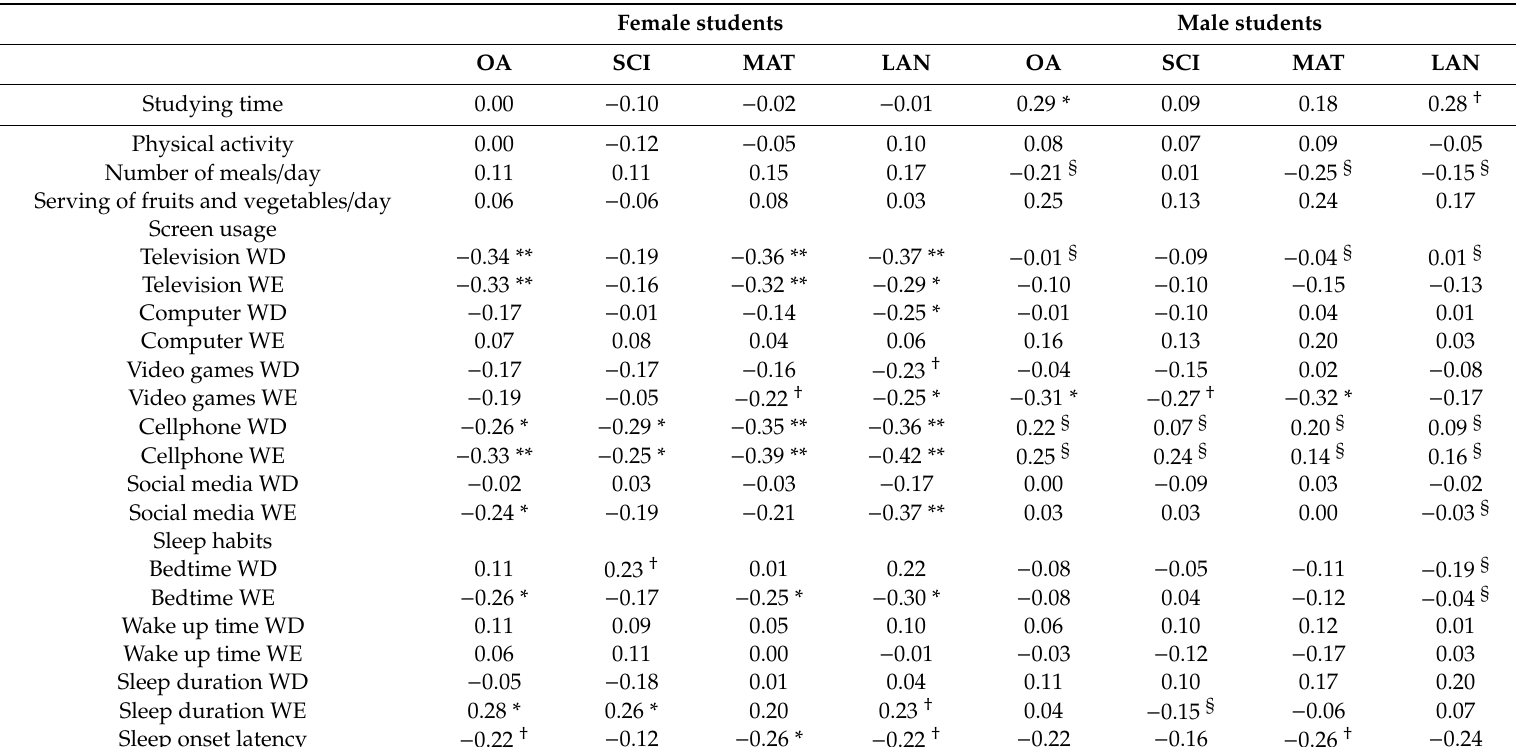
Table 4. Correlations between lifestyle habits with academic performance measures at baseline in high school female and male students. Female students Male students OA SCI MAT LAN OA SCI MAT LAN Studying time 0.00 Physical activity 0.00 Number of meals / day 0.11 Serving of fruits and vegetables / day 0.06 Screen usage